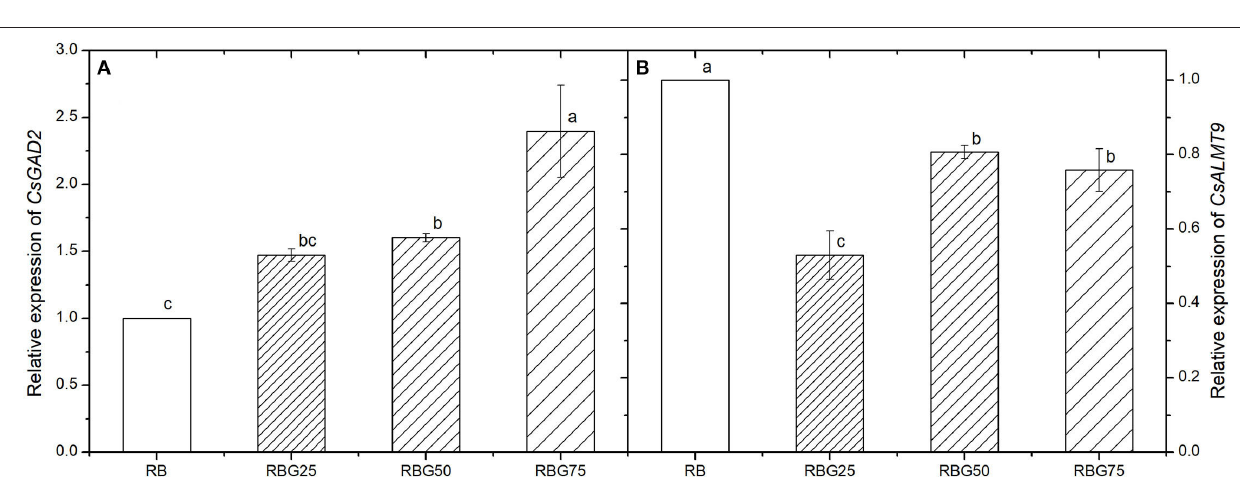
FIGURE 9 | Effect of different spectral conditions on relative expression levels of CsGAD2 and CsALMT9 in cucumber seedlings leaves after 9 days of drought stress. (A) The relative expression level of CsGAD2 . (B) The relative expression level of CsALMT9 . RB, RBG25, RBG50 and RBG75 are the different spectral conditions, respectively. The PPFD for all the treatments was 250 µ mol m − 2 s − 1 . The data presented were the means ± SE ( n = 3). Different lowercase letters on the bar chart indicated significant differences among treatments according to Tukey’s test ( p <